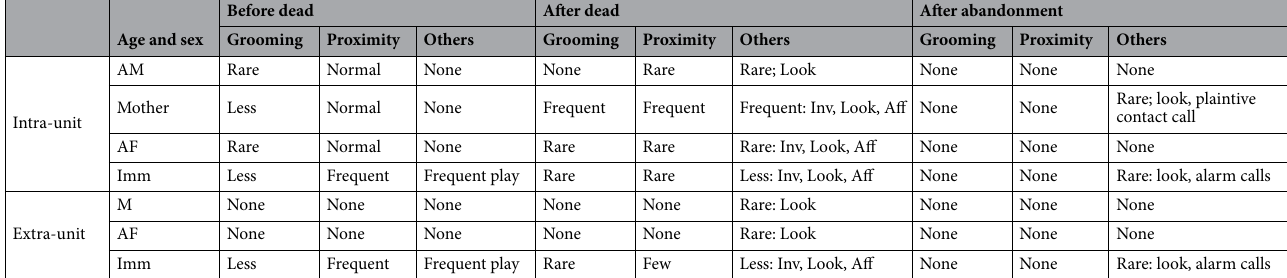
Table 2. Responses to the juvenile (alive and dead) by group members. AM: Adult-male, Mother: CM, AF: Adult-female, Imm: Immature (infant or juvenile); Inv: Investigate: includes looking closely, sniffing, briefly touching; Look: visual orientation toward target individual but with no close approach; Aff: affiliative behavior including grooming, embracing, or gentle manipulation.